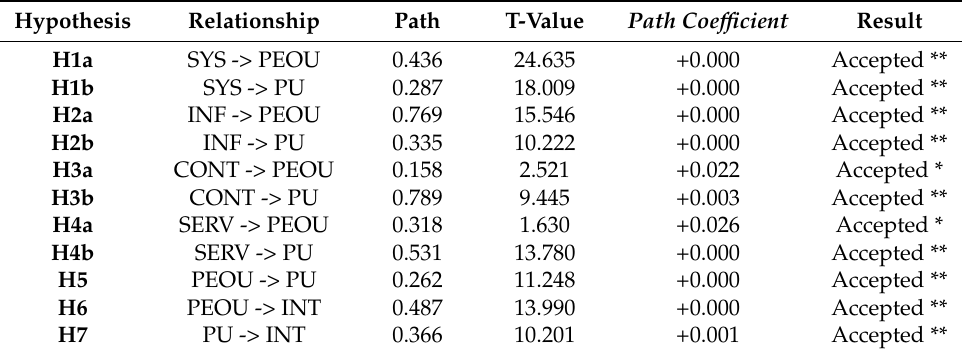
Table 9. Results of structural model examination (significant at * p < 0.05, ** p <